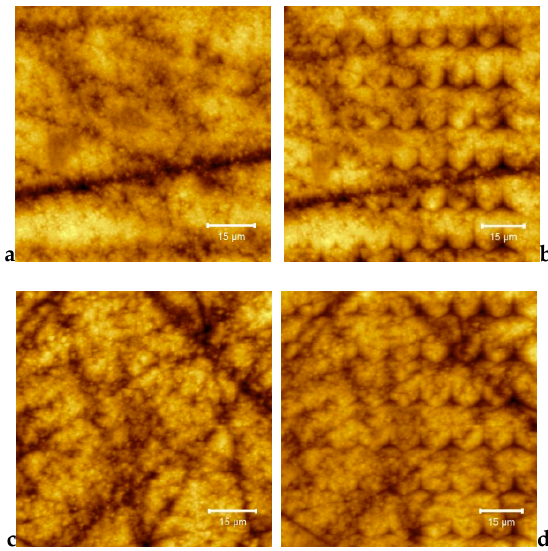
Figure 10. 80 × 80 µ m and 90 × 90 µ m 2D topography images of 3D-printed: ( a ) E-Dent 100 before and ( b ) after performing the indentation curves; ( c ) the newly obtained composite with 0.4% nanoTiO 2 before and ( d ) after performing the indentation curves.